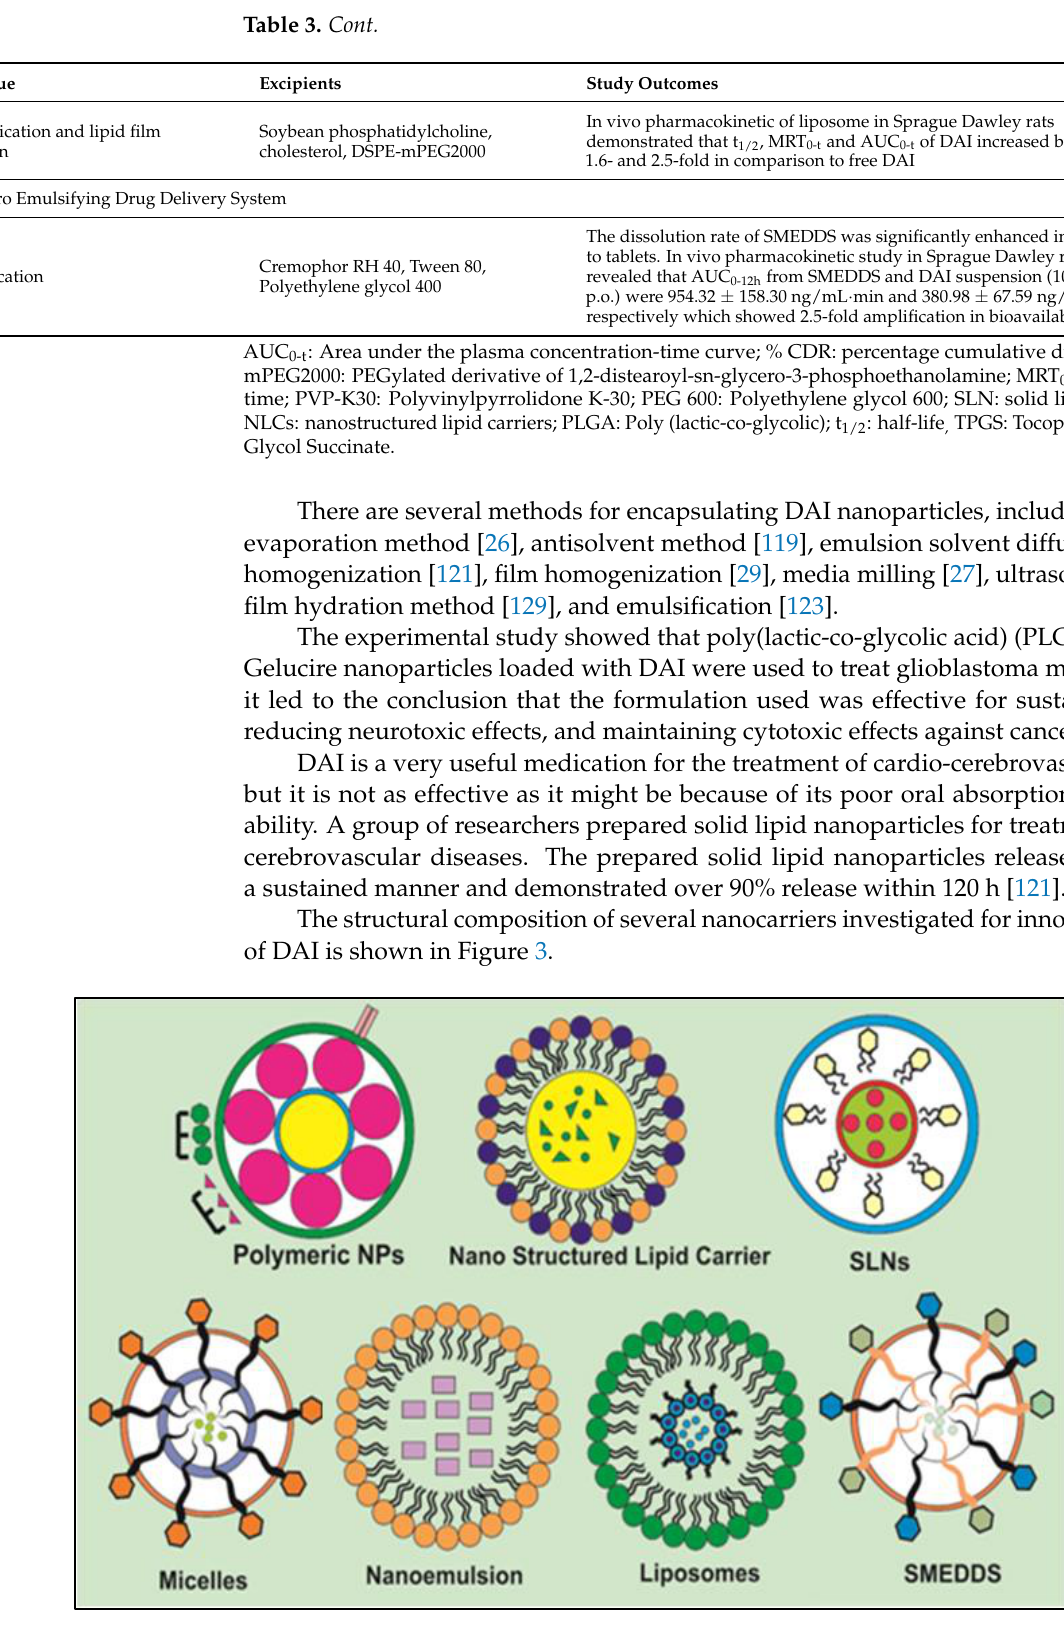
Figure 3. Structural composition of various nanocarriers explored for encapsulation of DAI regard- ing solubility and bioavailability